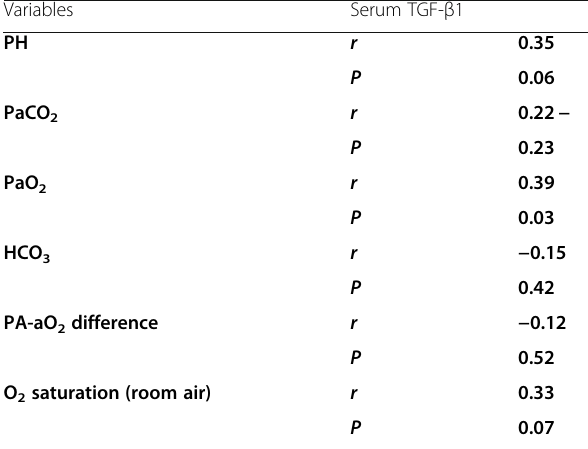
r : Pearson ’ s correlation, the sign before ( r ) represents the direction of correlation. P represents the significance of the correlation. P is considered significant if